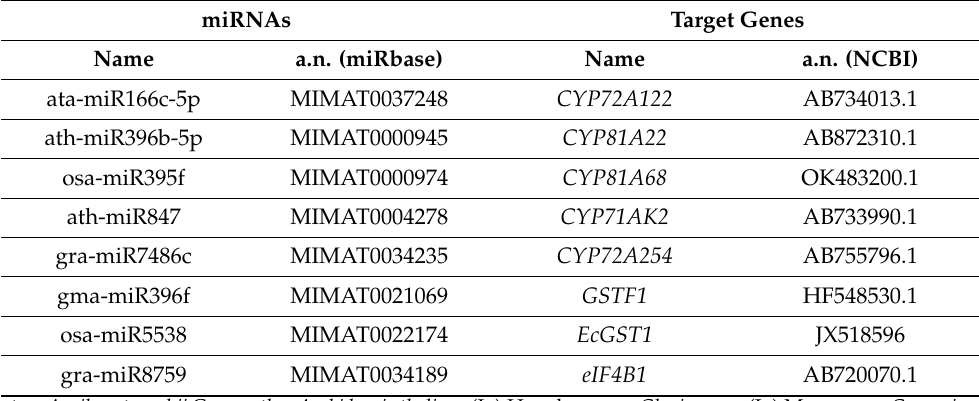
Table 1. miRNAs analyzed in Echinochloa crus-galli and their target genes.